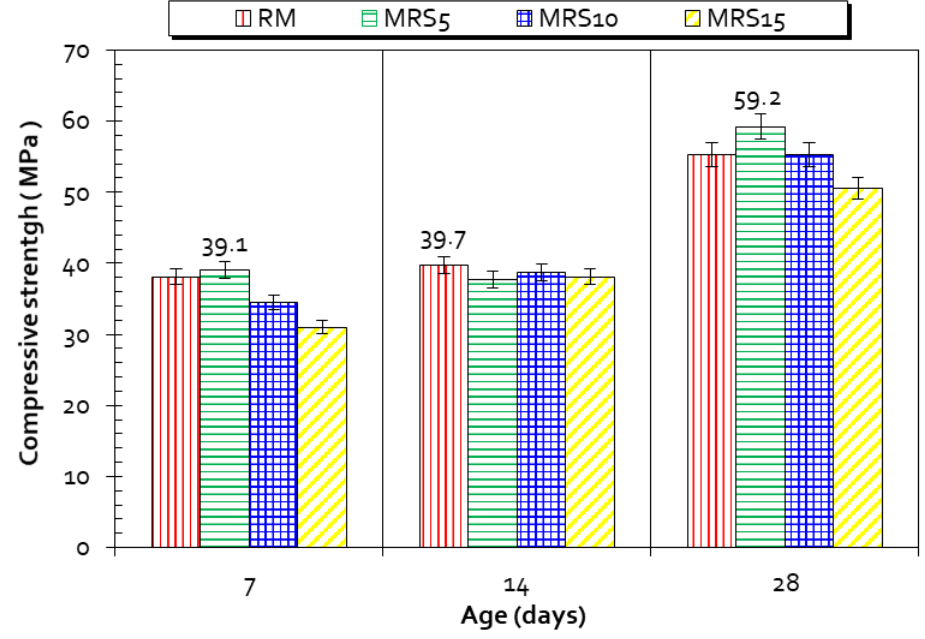
Figure 9. Compressive strength of RM and MRS, (5%, 10%, and 15%) mortars.